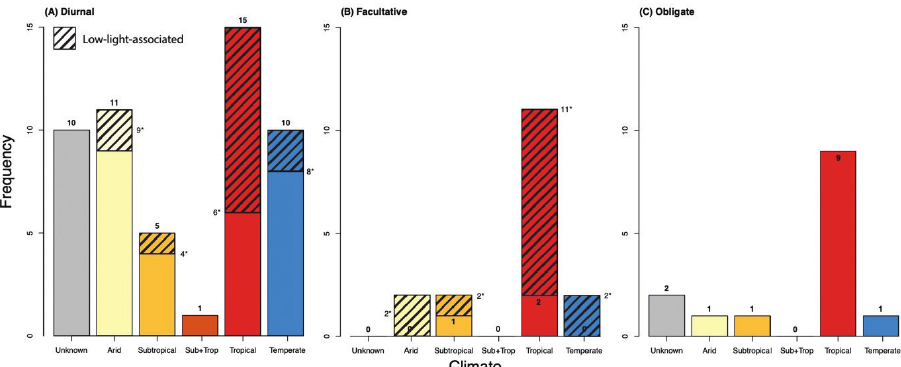
Figure 6. Stacked frequency histograms of the diurnal A facultative low-light B and obligate low-light C bee species by the climate in which they were most frequently collected. Unknowns represent the species that could not be identified reliably to species or, in the case of two low-light species, those with no reliable coordinates (Suppl. material 6: Fig. S5). Patterned bars represent ‘diurnal’ species that were associated with facultative species, according to our PCA analyses (Fig. 4, Table 2); these species are indi- cated twice once in ( A ) and once in ( B ). Bolded numbers indicate the behavioural assignment of species without reassigning behavioural state according to PCA results (Table 1), numbers with asterisks indicate values according to PCA assignment (Table